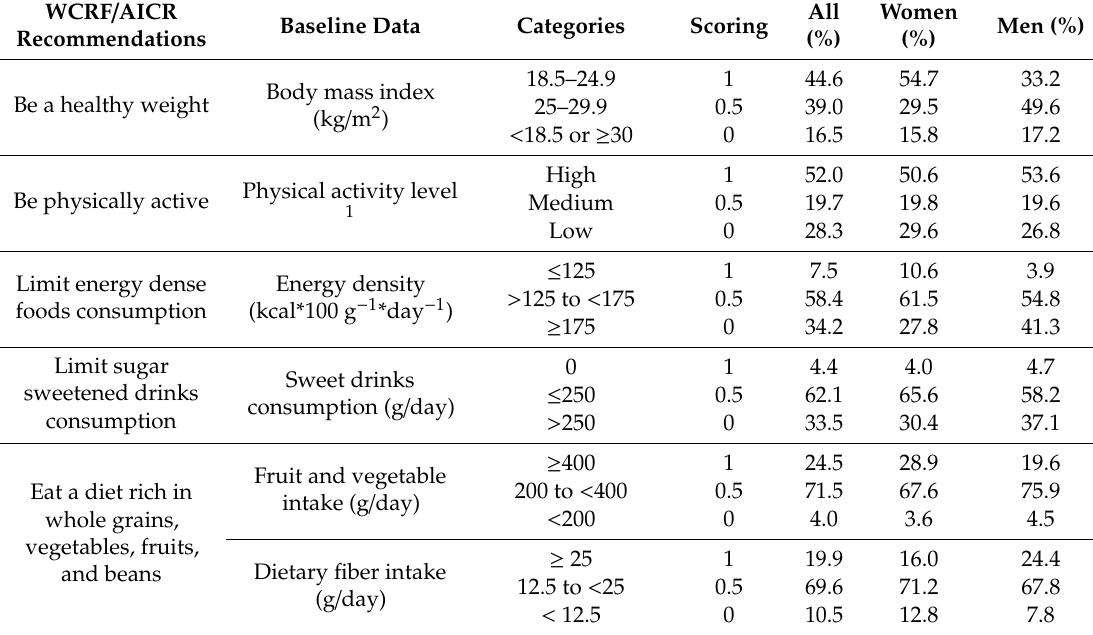
Table 1. Adherence to WCRF / AICR recommendations for cancer prevention in the EPIC Heidelberg subcohort and operationalization of the WCRF / AICR